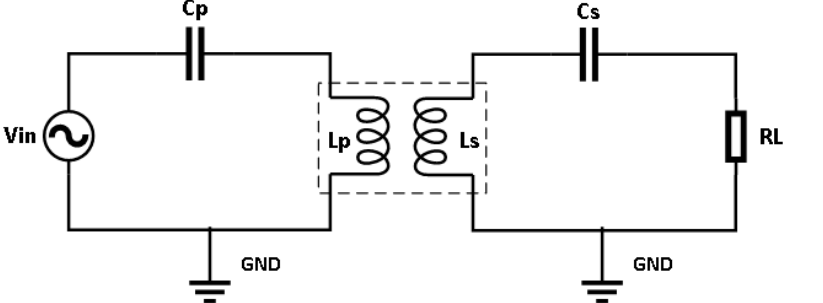
Figure 4. An equivalent circuit of a WPT system consists of a transmitter coil, receiver coil, and electrical elements.